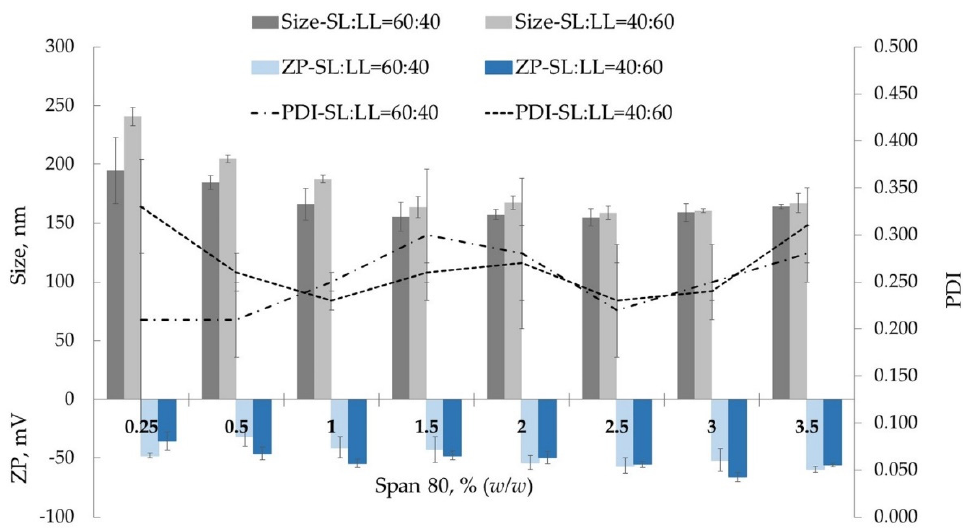
Figure 1. Influence of Span 80 concentration on particle size on NLC-SF .